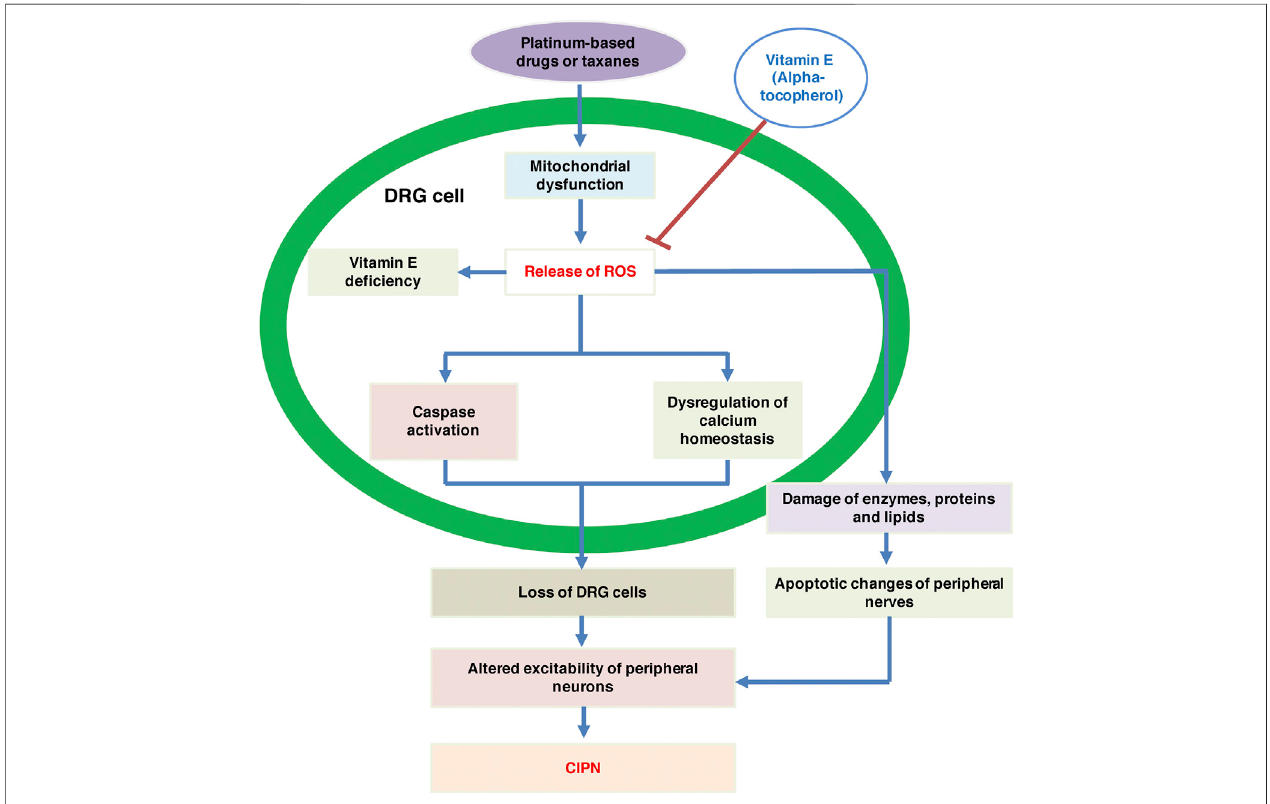
FIGURE1| ThepossiblemechanismsofvitaminEinCIPN.CIPN,chemotherapy-inducedperipheralneuropathy;DRG,dorsalrootganglion;ROS,reactiveoxygen species.